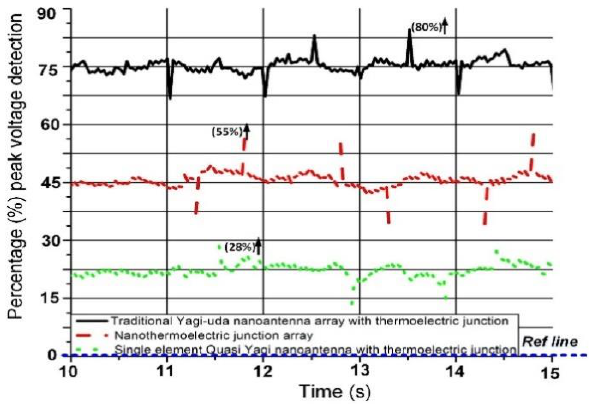
Table 3. Comparison with similar nanoantenna designs for detecting infrared energy. Ref.